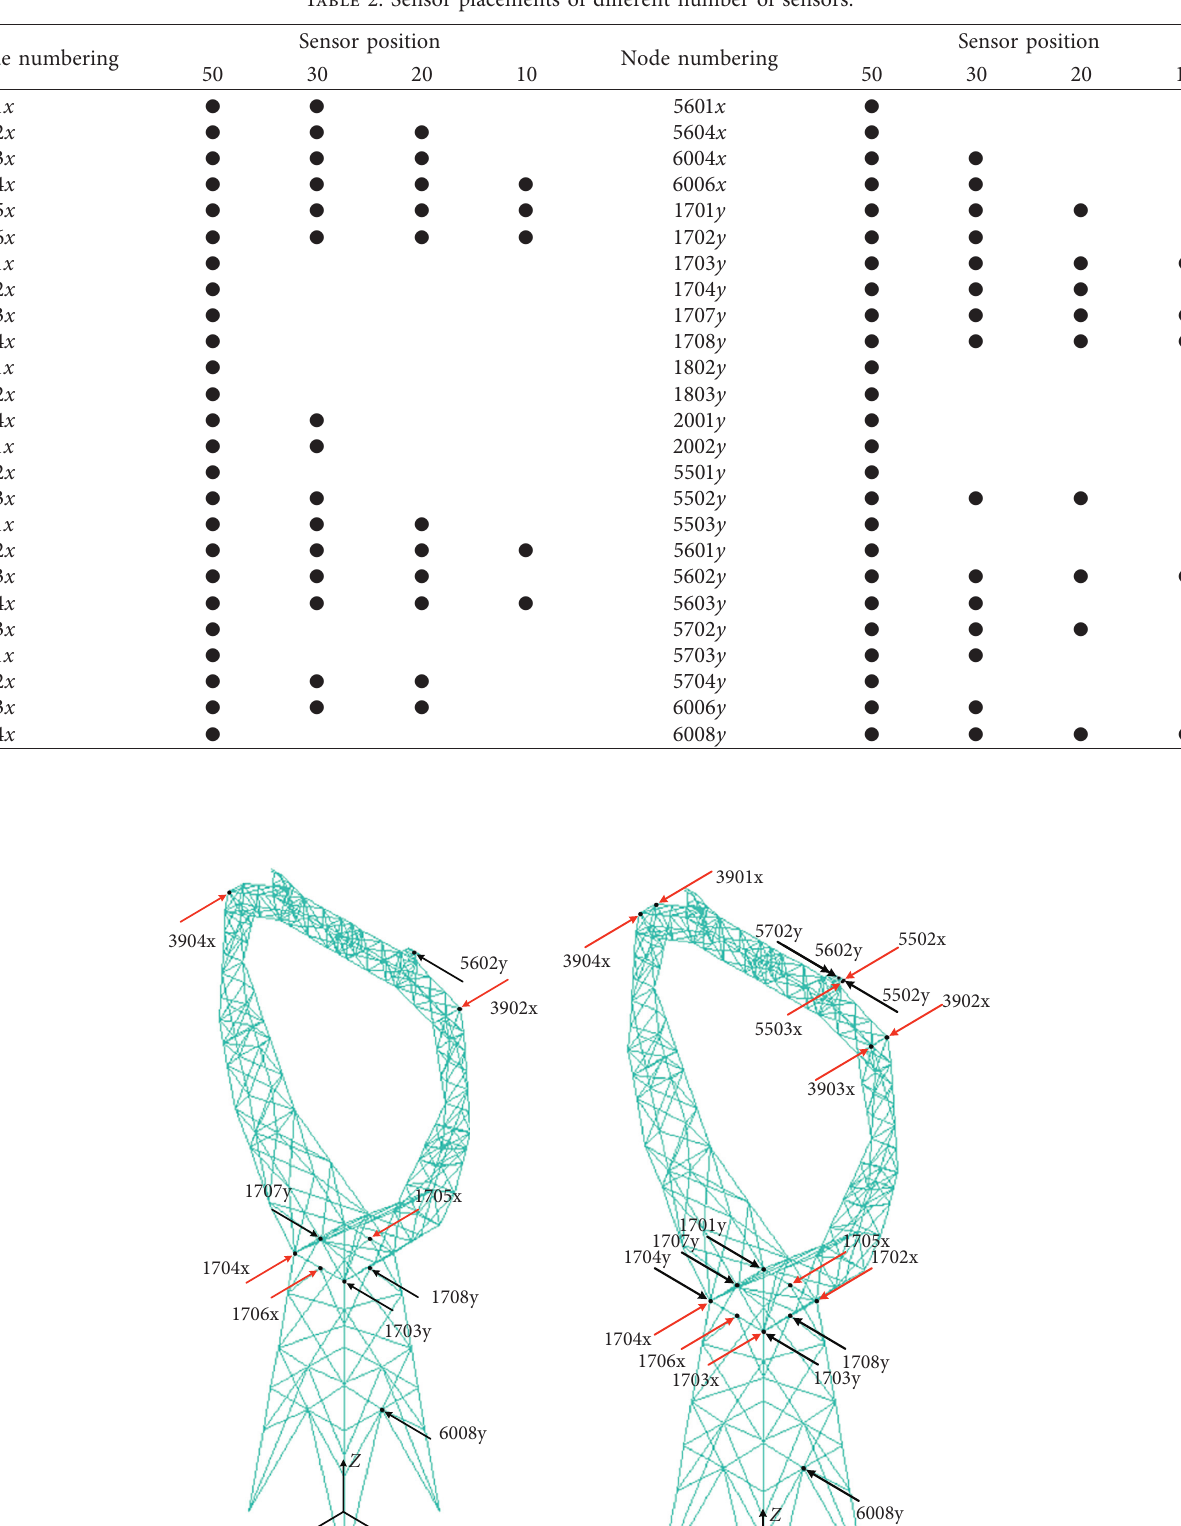
Table 2: Sensor placements of different number of